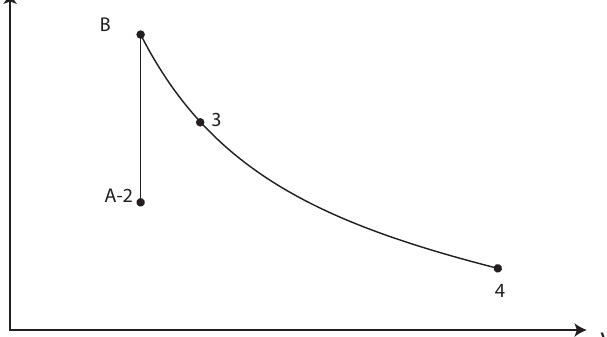
Figure 2. Pressure-specific volume diagram of the combustor